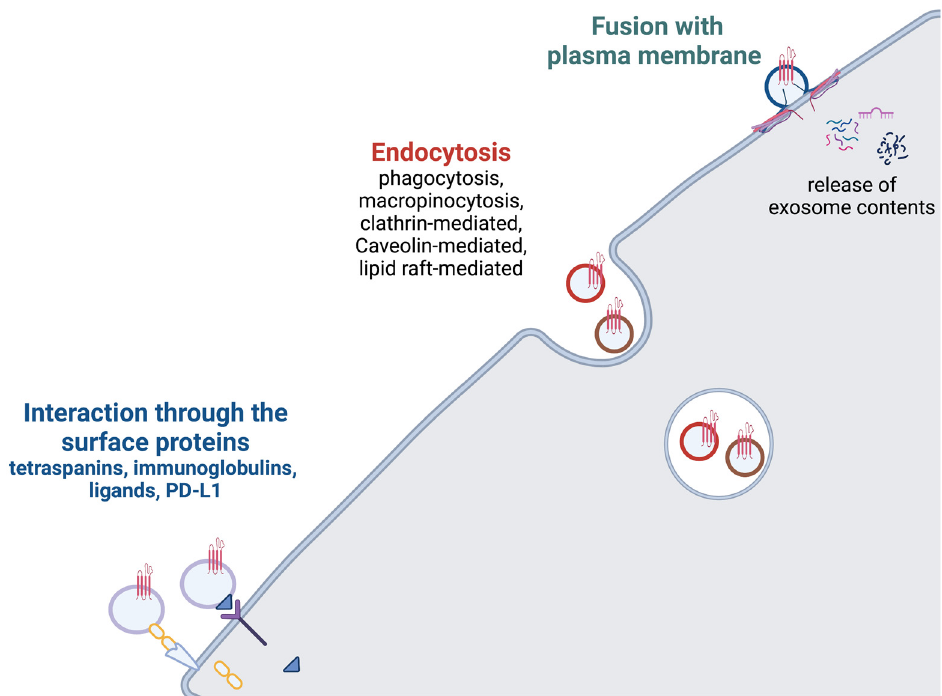
Figure 5. Exosome uptake. Exosome uptake occurs via one of three pathways: (1) Fusion with the plasma membrane to release exosome contents; (2) Endocytosis; (3) Direct interaction with surface receptors. Created with BioRender.com.